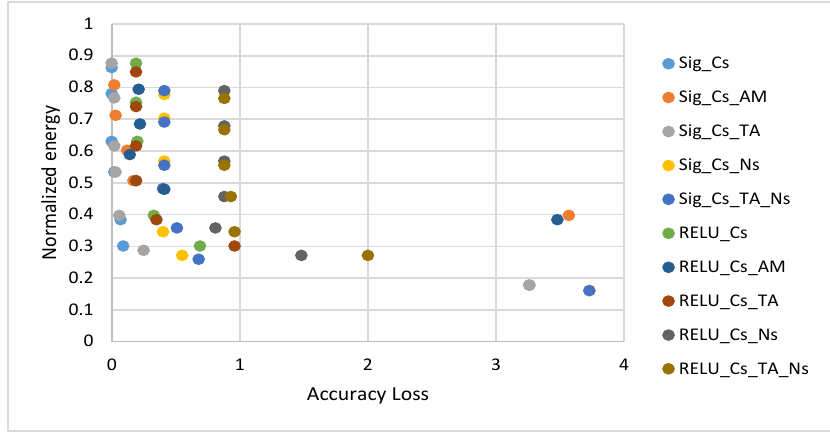
Figure 5. Approximation results for MNIST dataset, sig: Sigmoid activation function, Cs: Computation skipping, AM: Approximate Multiplier, TA: Truncated Accumulation, Ns: Neuron skipping, RELU: RELU activation function.